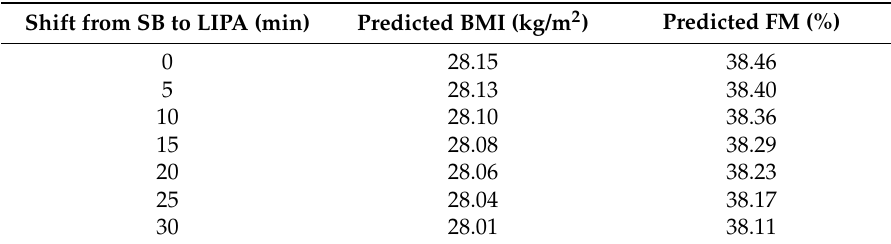
Table 5. Estimated BMI and FM% when reallocating between 0 and 30 min from SB to LIPA. Shift from SB to LIPA (min) Predicted BMI (kg/m 2